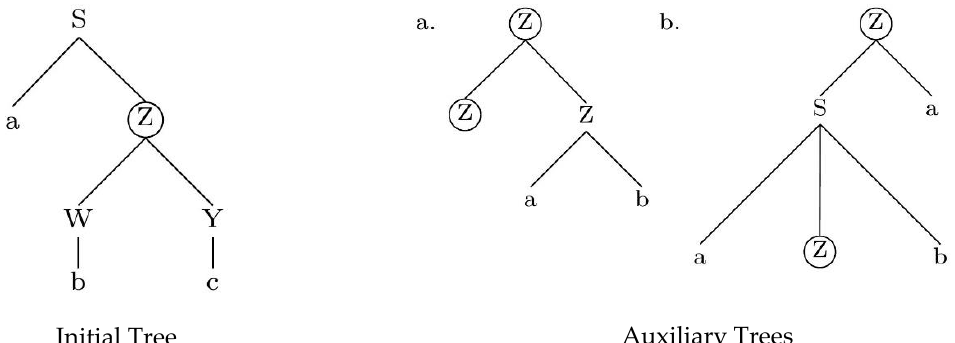
Figure 4. Initial and auxiliary trees. Auxiliary tree ( a ) features a recursive foot node immediately dominated by the root; auxiliary tree ( b ) features a foot node not immediately dominated by the root.